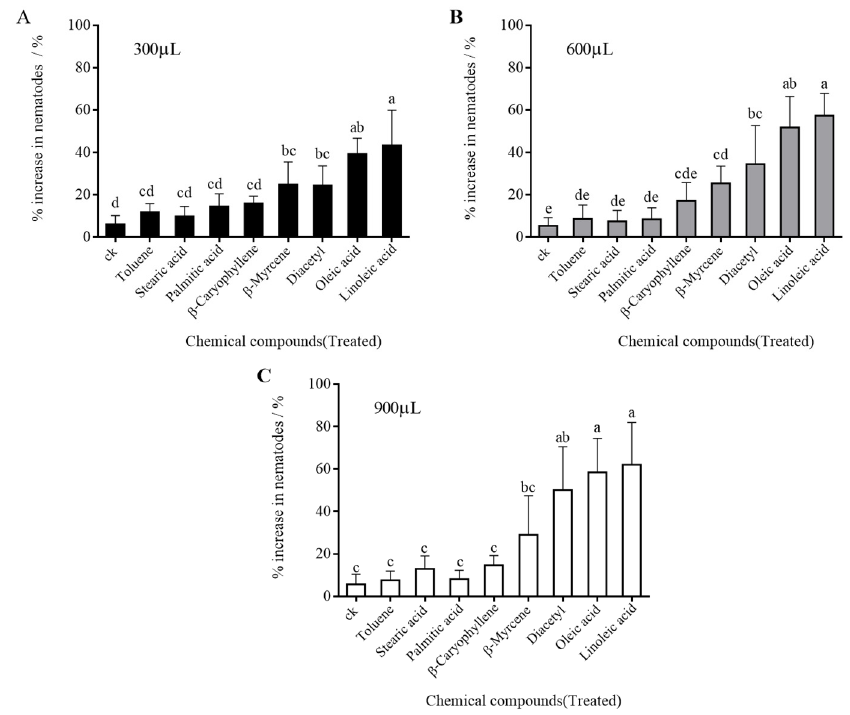
Figure 3. Changes in PWNs in infected woods treated with different attractant chemicals. ( A ) The dose of chemicals used was 300 µ L; ( B ) The dose of chemicals used was 600 µ L; ( C )The dose of chemicals used was 900 µ L. Lowercase letters indicate the differences among chemicals.